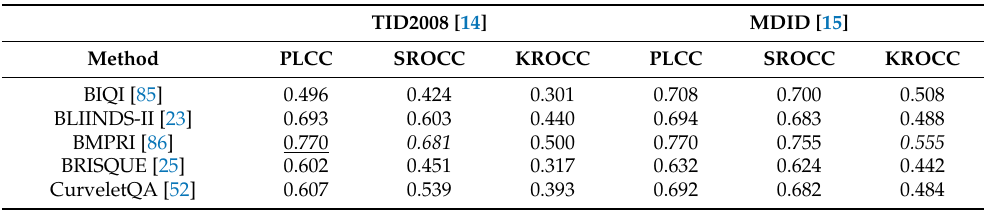
Table 5. Comparison to other state-of-the-art algorithms using TID2008 [14] and MDID [15] databases. Median PLCC, SROCC, and KROCC values were measured over 100 random train-test splits carried out with respect to the reference images. The best results are given in bold, the second-best results are underlined, and the third-best results are given in